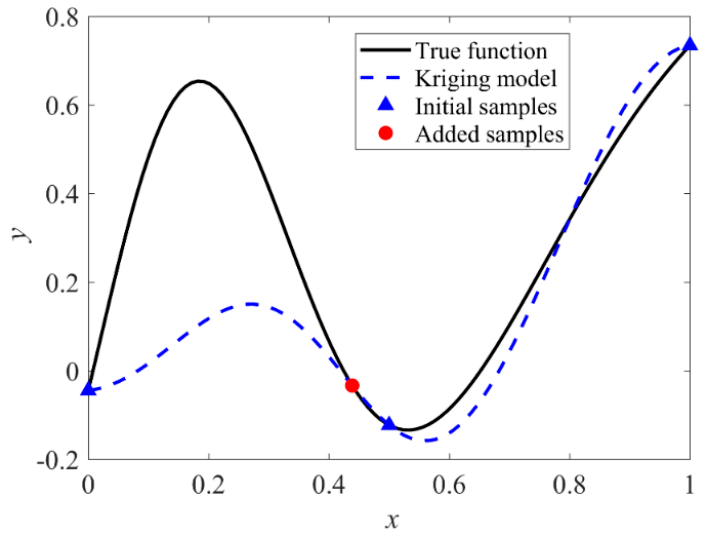
Figure 3. The first iteration of the proposed approach with the illustrated function.